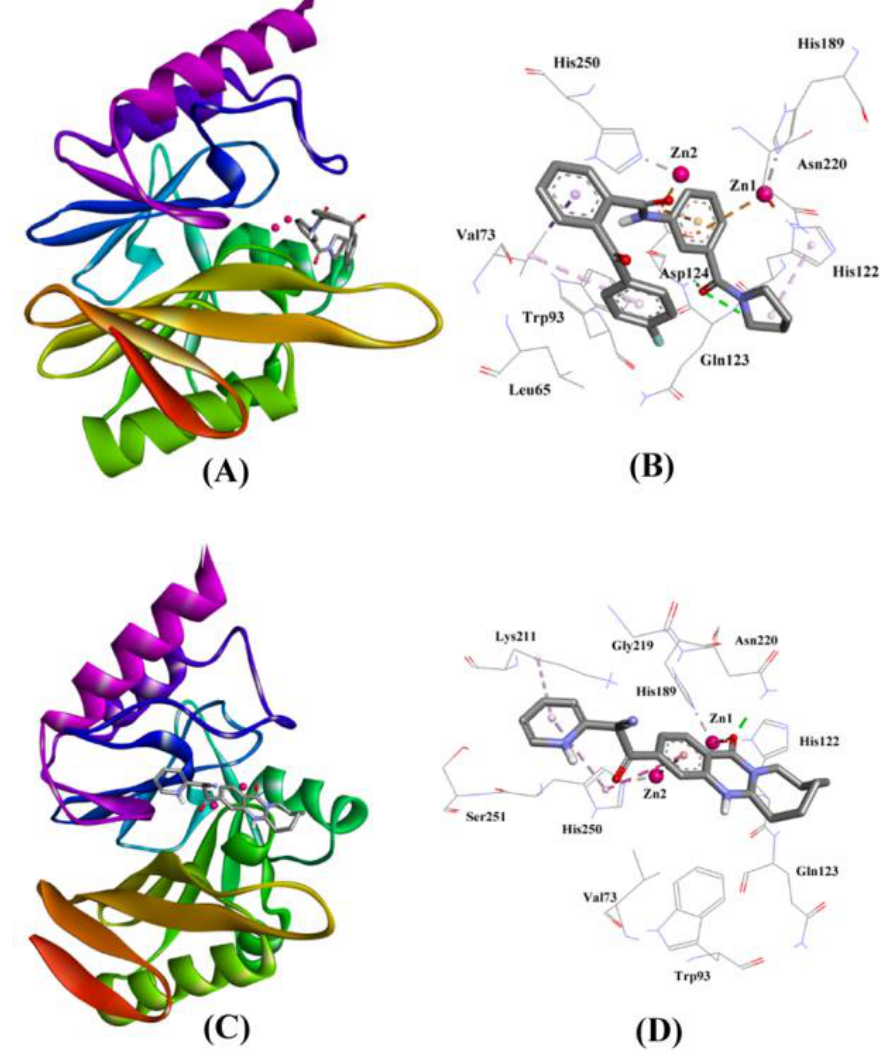
Figure 2. The molecular docking of ZINC30479078, and ZINC41493045 with of NDM-1. ( A ) The binding of ZINC30479078 at the active site cavity of NDM-1, ( B ) The molecular interactions between the amino acid residues of NDM-1 and ZINC30479078, ( C ) The binding of ZINC41493045 at the active site cavity of NDM-1, and ( D ) the molecular interactions between the amino acid residues of NDM-1 and ZINC41493045.